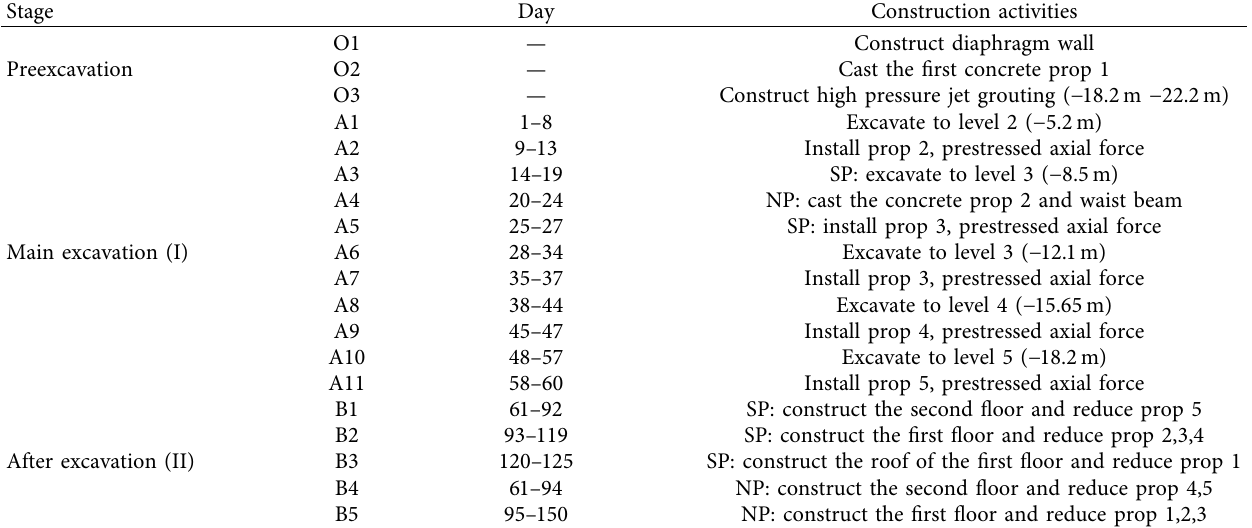
Table 1: Construction phases and sequence of the excavation.